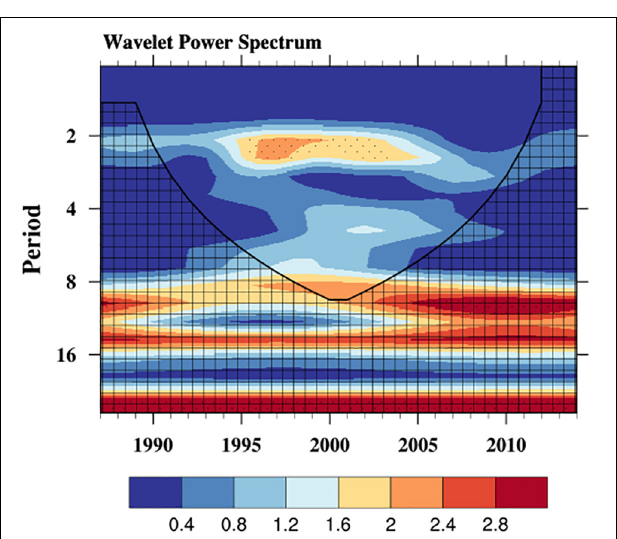
FIGURE 7 | The wavelet power spectrum for the winter season from 1987 to 2015 using the Morlet wavelet method. The shaded color denotes wavelet power. The hatched area delimits the “cone of influence,” which influenced by edge effect. The dotted points represent the significant at a 95% confidence